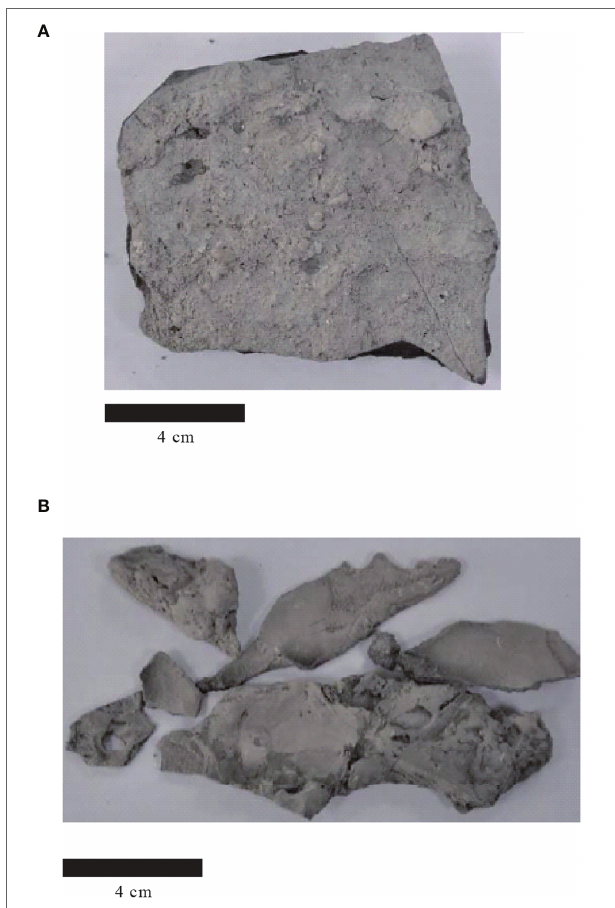
FIGURE 2 | Photographs of methane-derived authigenic carbonate (MDAC) from (A) 1.16 mbsf at Site ARA07C-St 13 and (B) 1.10 mbsf at Site ARA07C-St